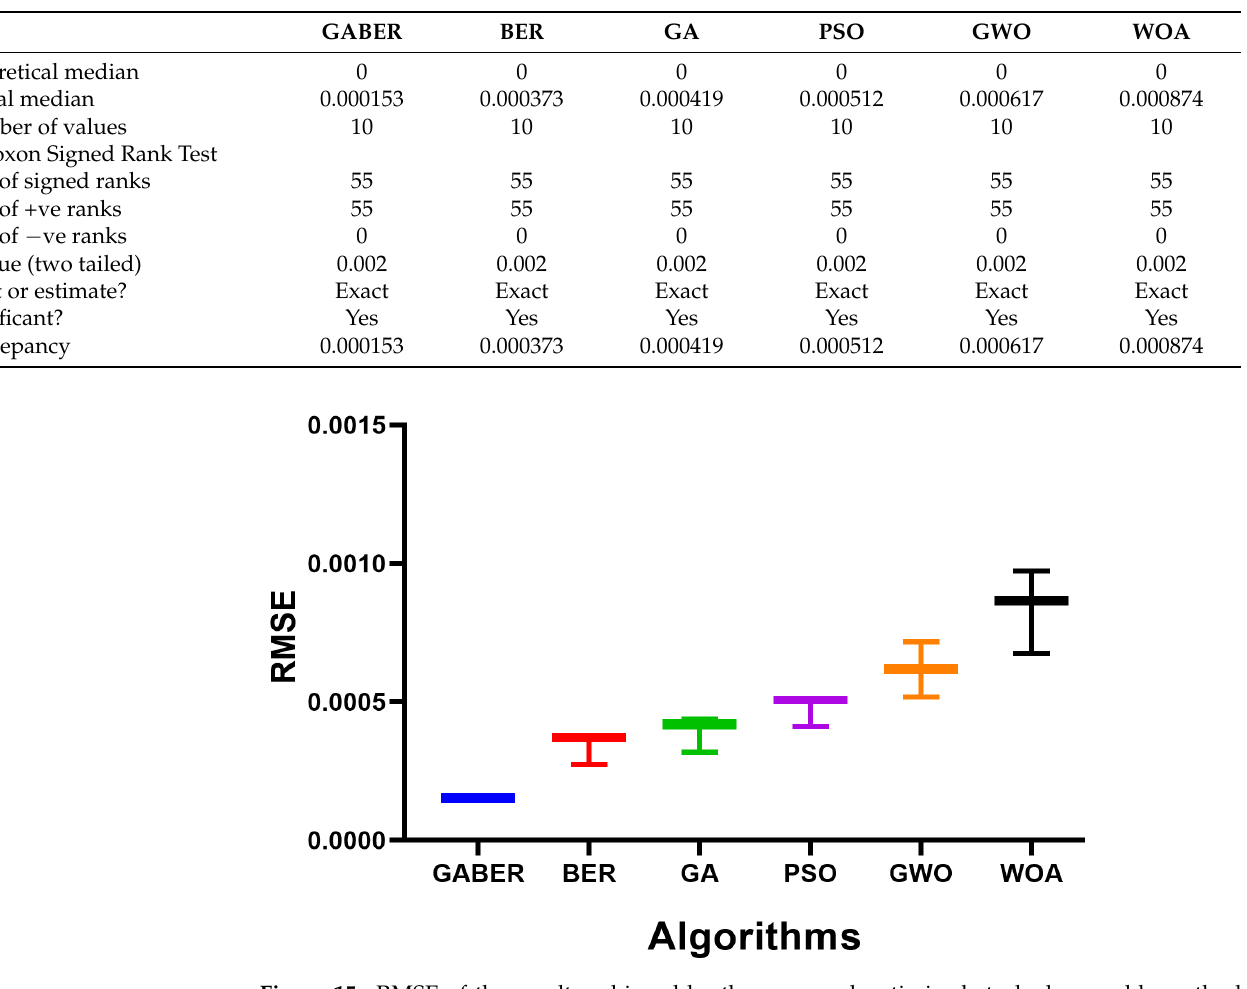
Figure 15. RMSE of the results achieved by the proposed optimized stacked ensemble method compared to other methods applied to the solar radiation